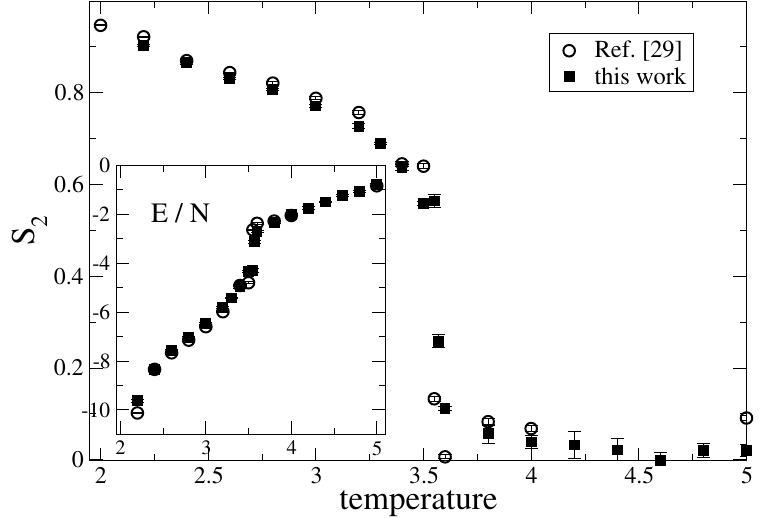
as a function 11